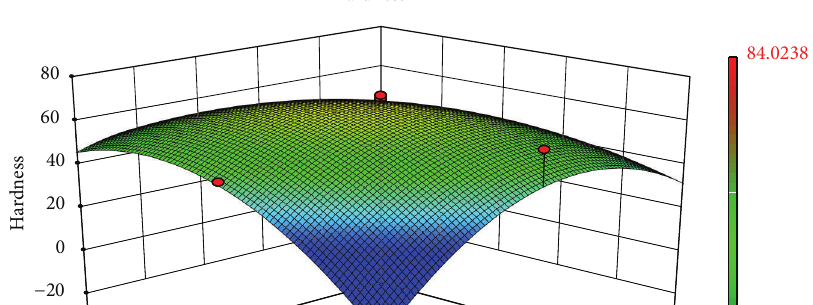
The total effect of ammonium bicarbonate on all the sensory parameters was significant at 𝑃 < 0.01 except taste ( 𝑃 < 0.05 ). The ammonium bicarbonate affected the OAA significantly ( 𝑃 < 0.01 ) at quadratic